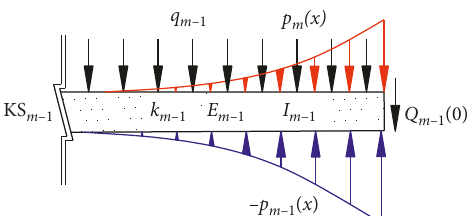
Figure 6: Stress analysis of the fissure zone KS on the coal mass